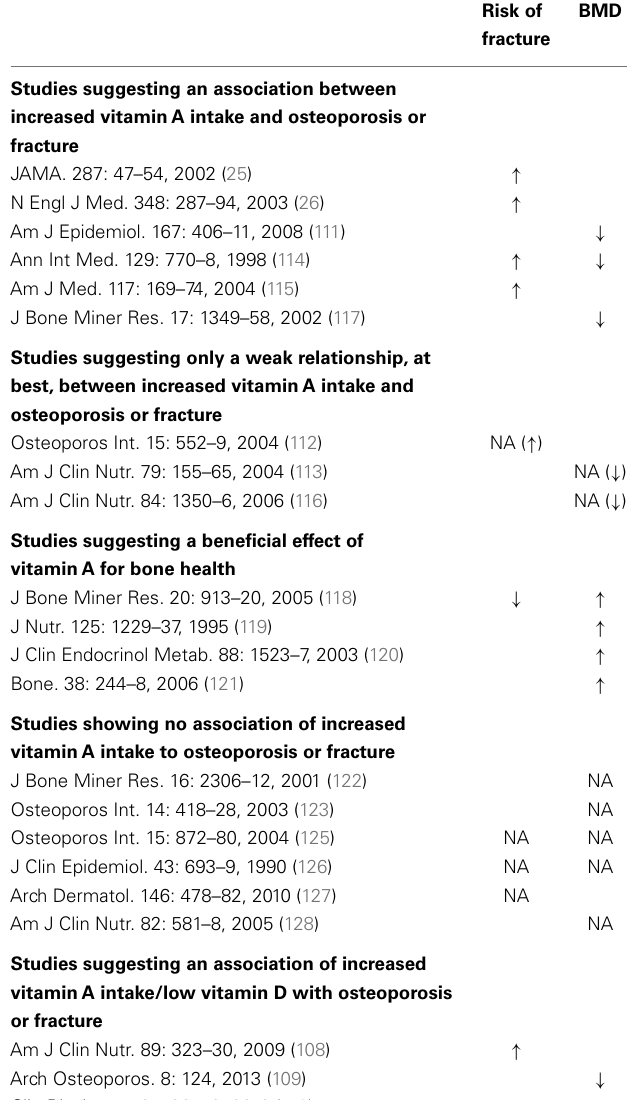
Table 1 | Human studies evaluating the risk of fractures and BMD to determine the impact of increased vitaminA intake on bone health .